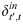
Reconstructing delay times from electrophysiological recordings.The physiological delay between two measurement points v
s, v
t consists of the time needed for information transfer via axonal connections (δ
s,t′) and internal computation within populations of neurons (δt′,tin), such that in a network representation of reconstructed interactions we find w(vs,vt)=δs,t′+δt′,tin. Black arrows represent information transfer within the neural microcircuits.